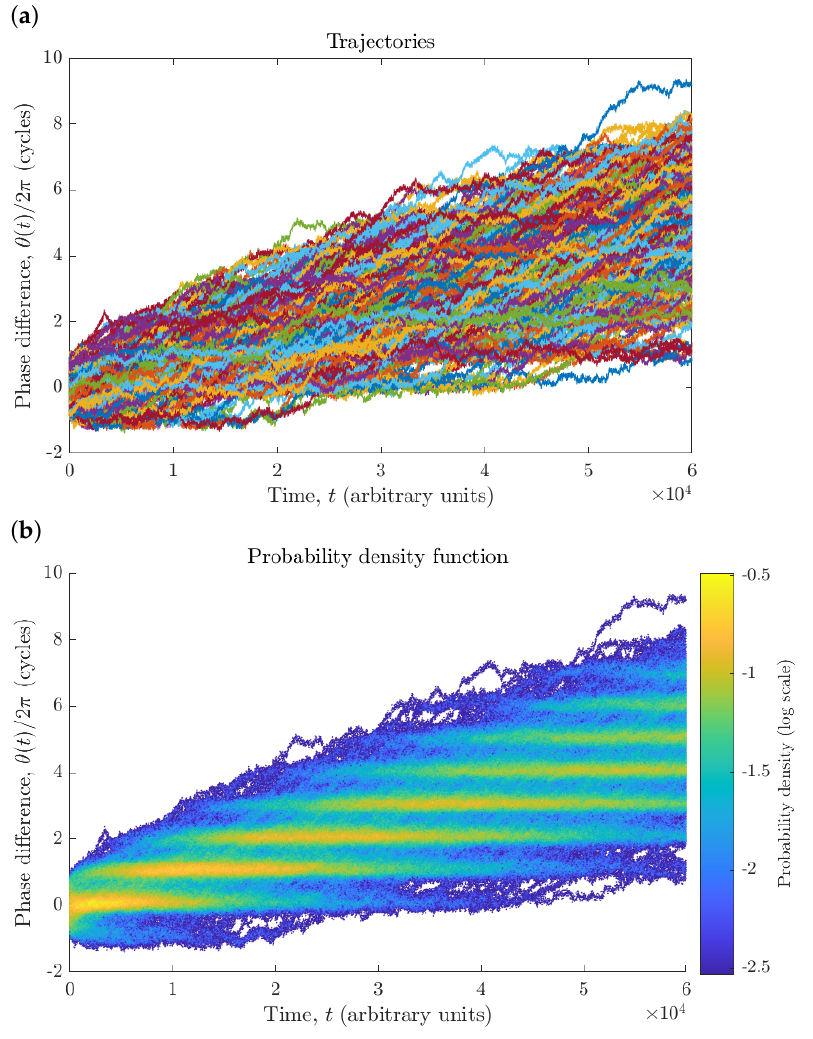
Figure 3. ( a ) Deterministic trajectories of phase difference θ ( t ) for random initial conditions and ( b ) corresponding probability density function, for coupling strength κ =